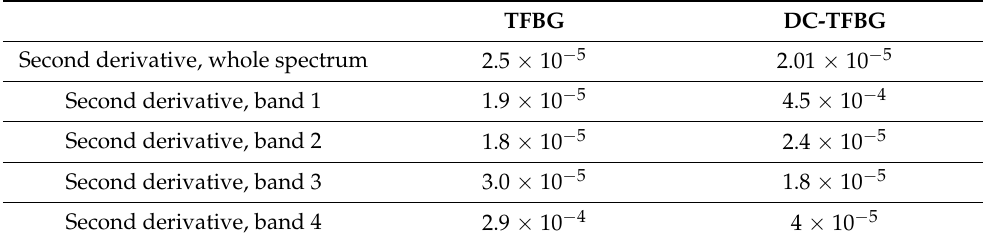
Figure 18. The wavelength of the second derivative maximum of the cumulative contour spectrum for TFBG and DCTFBG. Table 4. Comparison of the resolution for wavelength of the maximum of the second derivative for the TFBG and the DCTFBG for optical spectra for individual frequency ranges.